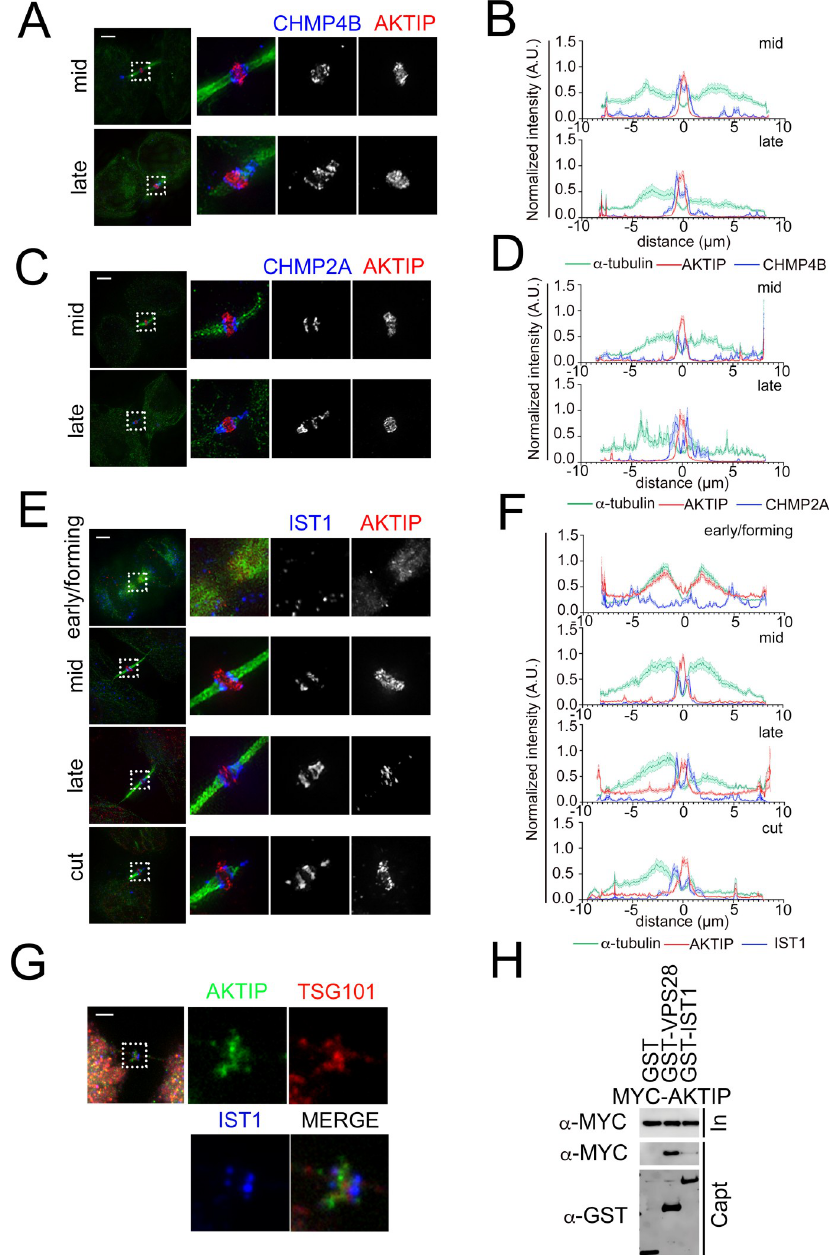
Fig 4. The supra-molecular structure of AKTIP is flanked by the rings formed by the ESCRT III components. (A, C, E) 3D-SIM images of ESCRT III components CHMP4B (A), CHMP2A (C), IST1 (E) and AKTIP in HeLa cells. Staining with antibodies against ESCRT III (blue), AKTIP (red) and α -tubulin (green). (B, D, F) Representative fluorescence intensity profile plotted for AKTIP, ESCRT III subunits and α -tubulin along the midbodies at different stages. (B) mid, n = 6; late, n = 4. (D) mid, n = 6; late, n = 3. (F) early/forming, n = 6; mid, n = 7; late, n = 8; cut, n = 6. (G) Spinning disk microscopy images of IST1 (blue), AKTIP (green) and TSG101 (red). Scale bars, 2.5 μ m. (H) Western blotting showing that AKTIP interacts with GST-VPS28, but not with GST-IST1 or GST alone. Cells were transfected with plasmids encoding the indicated fusion proteins. Purified GST-VPS28 or GST-IST1 or GST alone were used to pull down interacting proteins; cell lysates and glutathione-bound fractions were then analyzed with MYC and GST antisera. GST-pull downs were repeated three